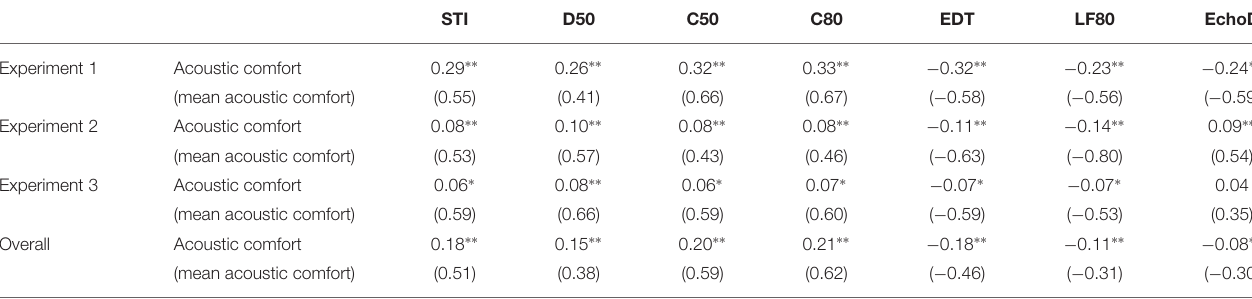
TABLE 2 | Pearson’s r for correlations between room acoustical parameters and acoustic comfort (and mean acoustic comfort).